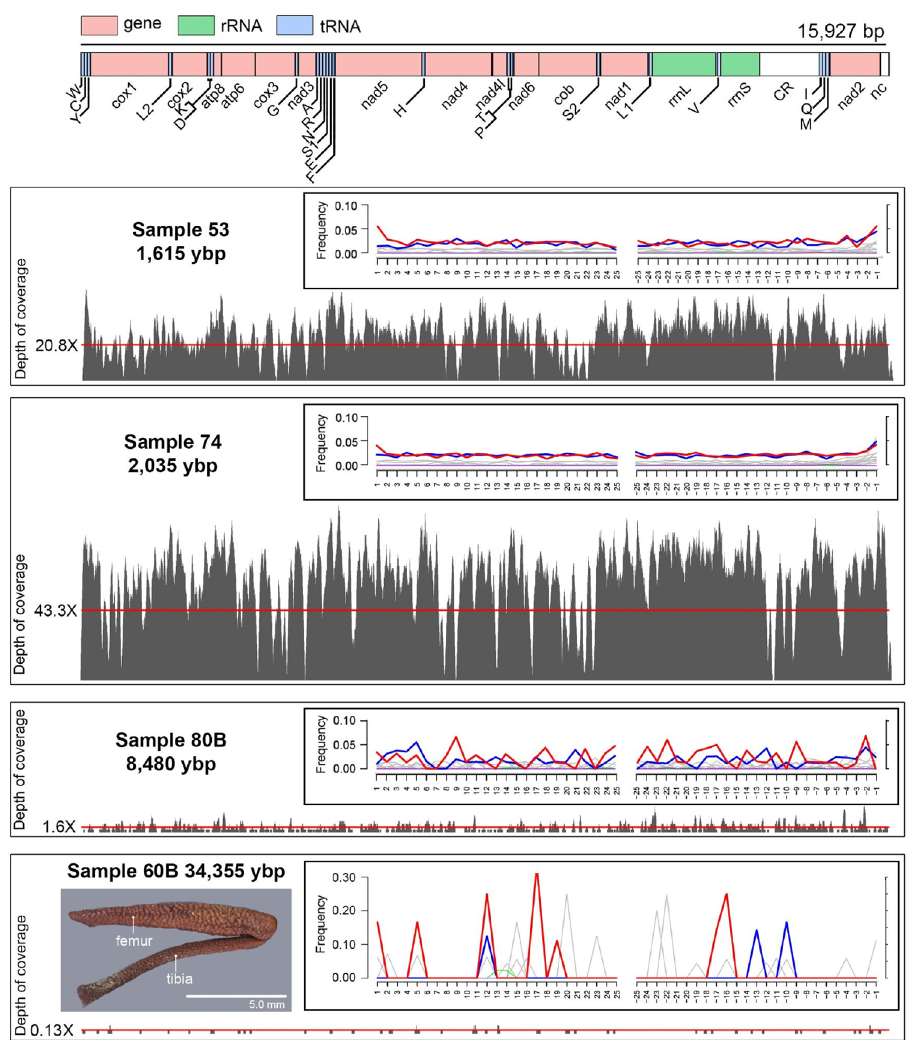
Figure 1. Gene arrangement and read depth along reconstructed ancient mitochondrial genomes. All aDNA reads were mapped in BWA v.0.7.17 to the Philolithus actuosus TB20958 (Tenebrionidae: Asidini) mitogenome. Asterisk indicates samples containing > 1% ambiguous sequences from lack of coverage. Red lines mark average coverage. White fields represent control (CR) and other non-coding regions (nc). Color codes: Red: C to T substitutions; Blue: G to A substitutions; Grey: All other substitutions; Orange: Soft-clipped bases; Green: Deletions relative to the reference; Purple: Insertions relative to the reference. Subfossil fragments ( Philolithus actuosus ) used in the extraction process were illustrated for 34,355 ybp